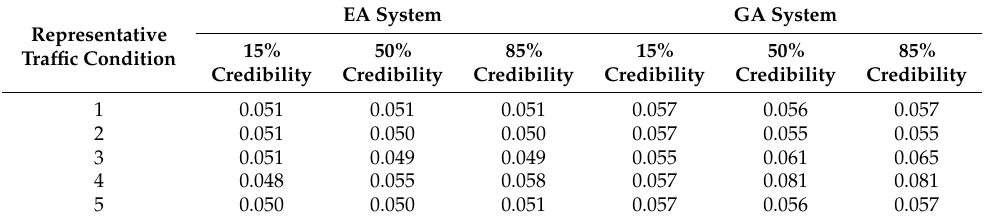
Table 5. Total uncertainty of LCC of SBDPS under representative traffic